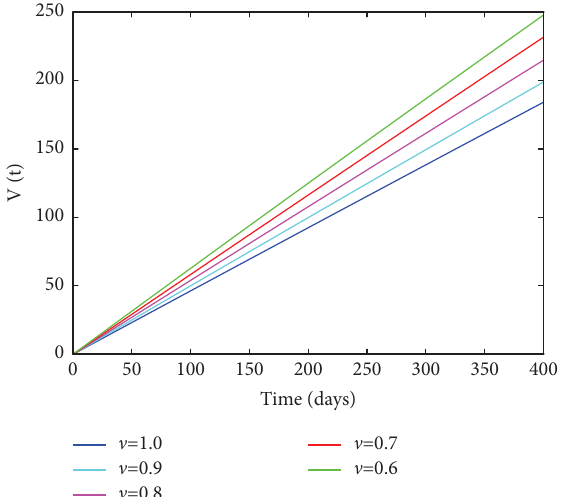
Figure 7: Behaviour of the vaccinated individuals at diferent values of v .